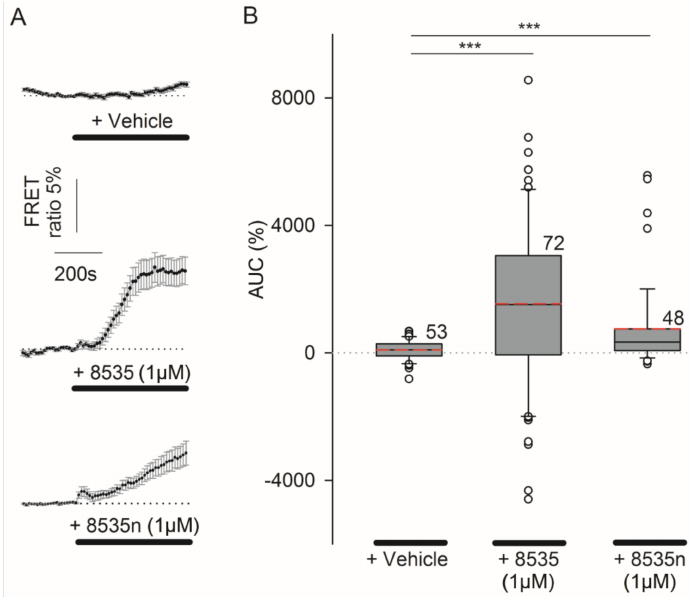
Figure 6. The GPR27 surrogate agonist 8535-induced increase in [lactate] i in astrocytes. Astrocytes were stimulated with 8535 or 8535n, surrogate agonists of GPR27, and cytosolic lactate ([lactate] i ) was measured by the FRET-based nanosensor Laconic. ( A ) Average normalized time course of the Laconic FRET ratio signal (mTFP/Venus) with the addition of vehicle ( top panel), 8535 (1 µ M, middle panel) or 8535n (1 µ M, lower panel). Horizontal black lines indicate the presence of stimuli; the horizontal dotted lines represent the relative baseline value of 1. ( B ) Boxplots compare the median values of the area under the curve (AUC, %) of the Laconic FRET ratio signal on the addition of vehicle, 8535 (1 µ M) and 8535n (1 µ M). Red dashed lines in the boxes represent the average values; white circles are outliers. One-way ANOVA on ranks was used. Mann–Whitney rank sum tests were used for the comparison of isolated groups (*** p ≤ 0.001). Numbers adjacent to boxes are the number of cells analyzed and prepared from at least three